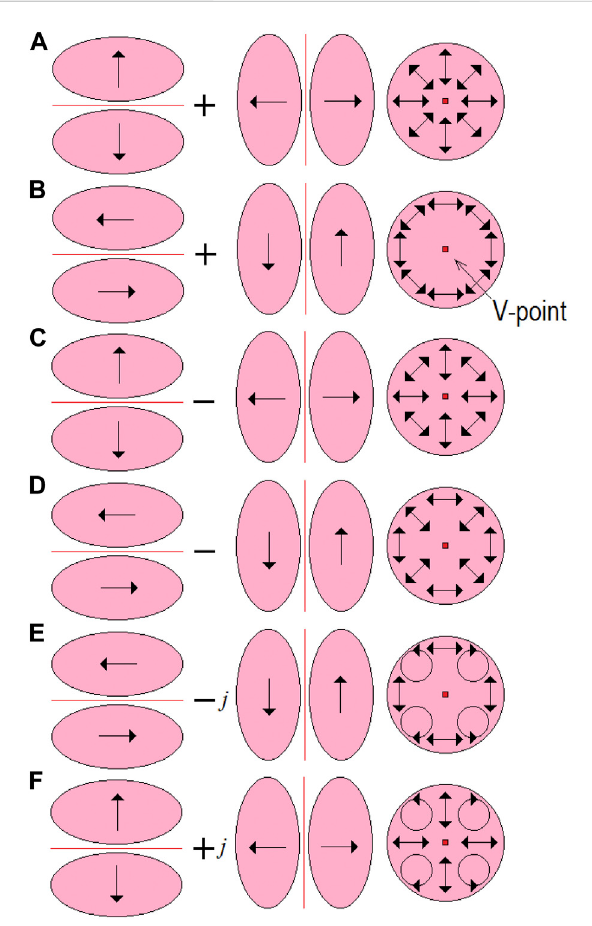
FIGURE 6 Polarization structure of some cylindrical vector beams formed as superpositions of the modes TF 01 (TE 10 ). (A , B) Beams with radial and azimuthal polarizations (phase difference between the TE components Eq. 3.9 equals to zero); (C , D) beams with “ twisting ” polarization (phase difference between the TE components is π ); (E , F) beamswithvariableellipticpolarization(phasedifferencebetweenthe TE components is − π /2 and + π /2,